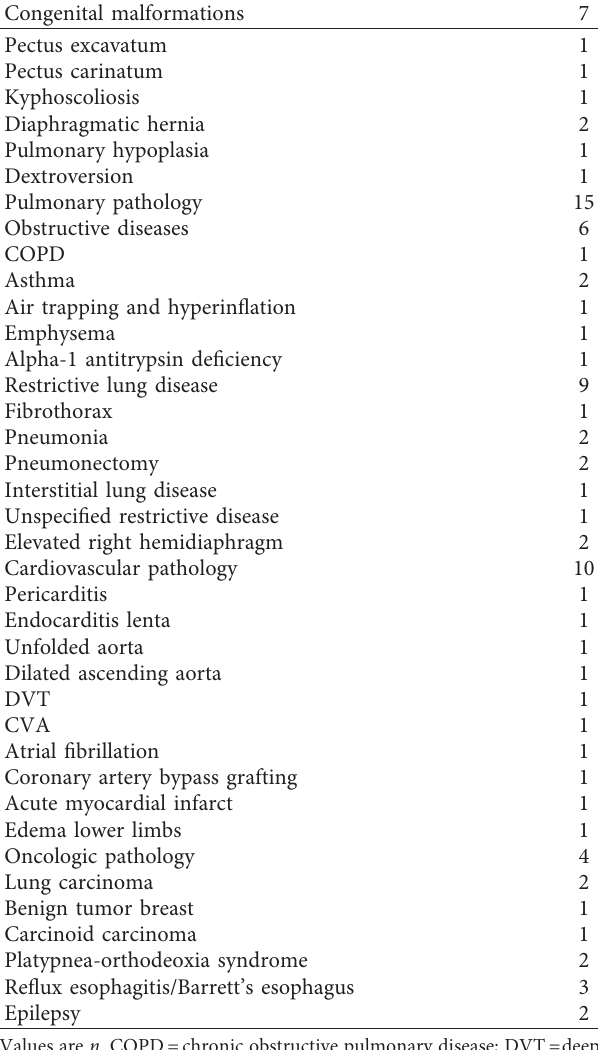
Table 3: Most relevant associated